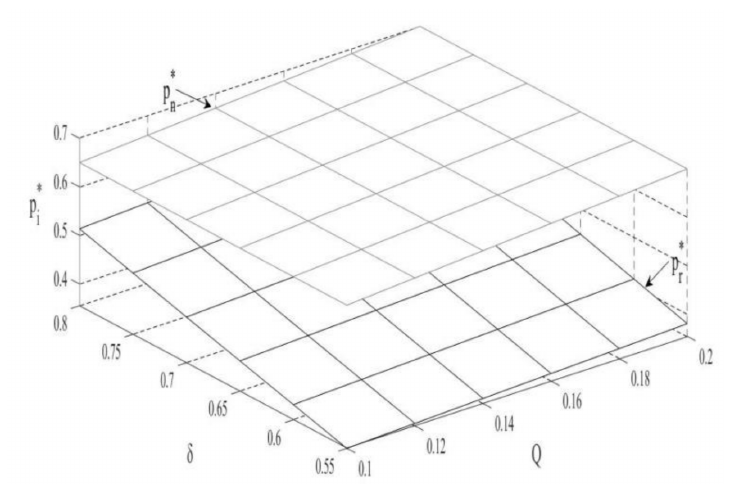
Figure 1. The impact of Q and δ on the unit retail